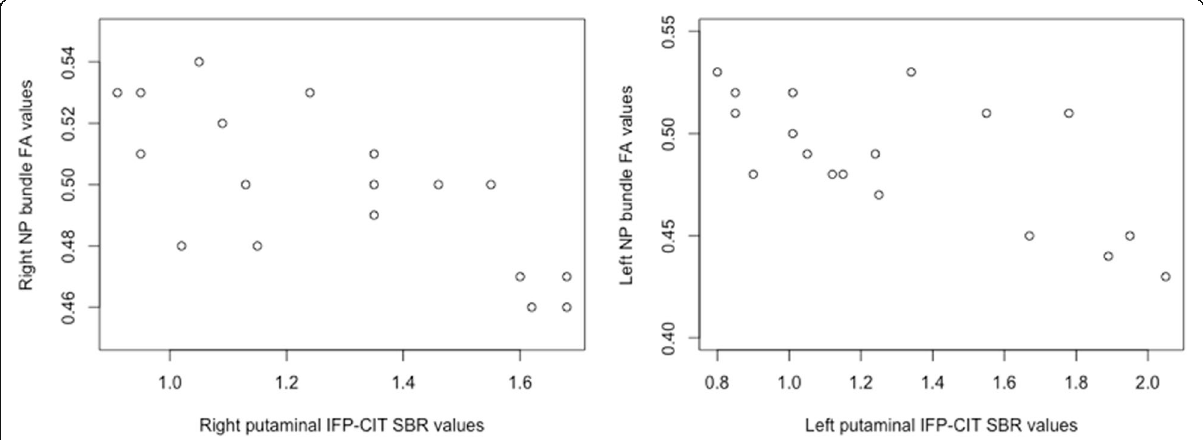
Fig. 4 Correlations between putaminal 123 IFP-CIT specific binding ratio (SBR) values and nigroputaminal (NP) fractional anisotropy (FA) in patients with dementia with Lewy bodies. Note the significant (right, r = -0.720, p = 0.001; left, r = -0.670, p = 0.003) inverse correlation between putaminal SBR values at 123